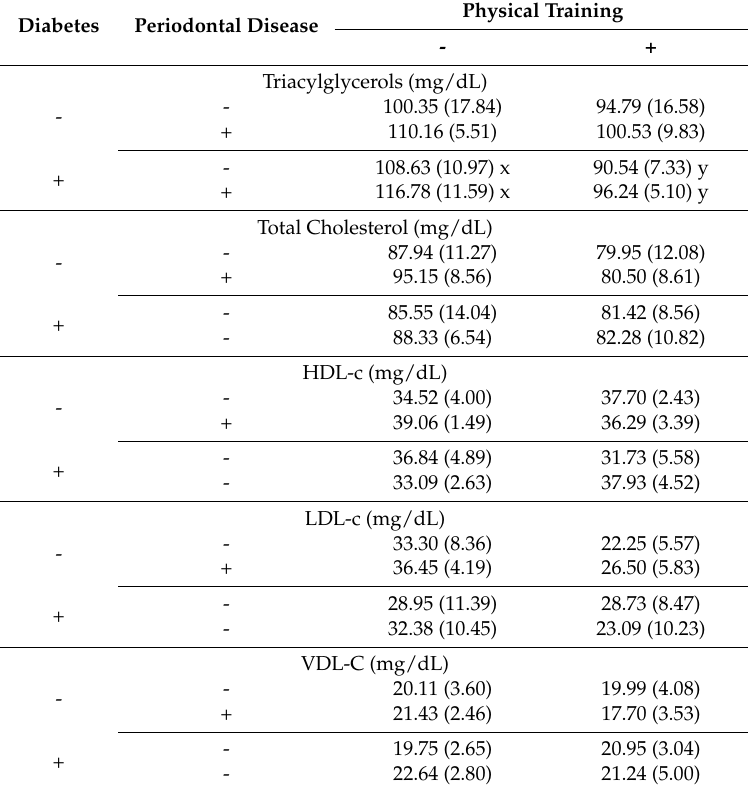
x,y Different letters in the lines indicate differences between the groups with and without physical training (F test— p < 0.05). HDL-c—High Density Lipoprotein. LDL-c—Low Density Lipoprotein. VLDL-c—Very Low Density Lipoprotein. “-“—Without.